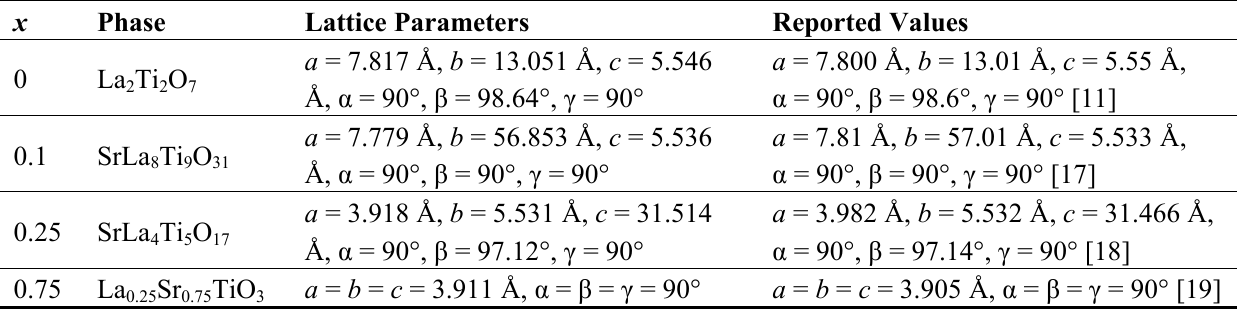
Sr TiO as functions of x (0 ≤ x < 1). 1− x x 3+δ